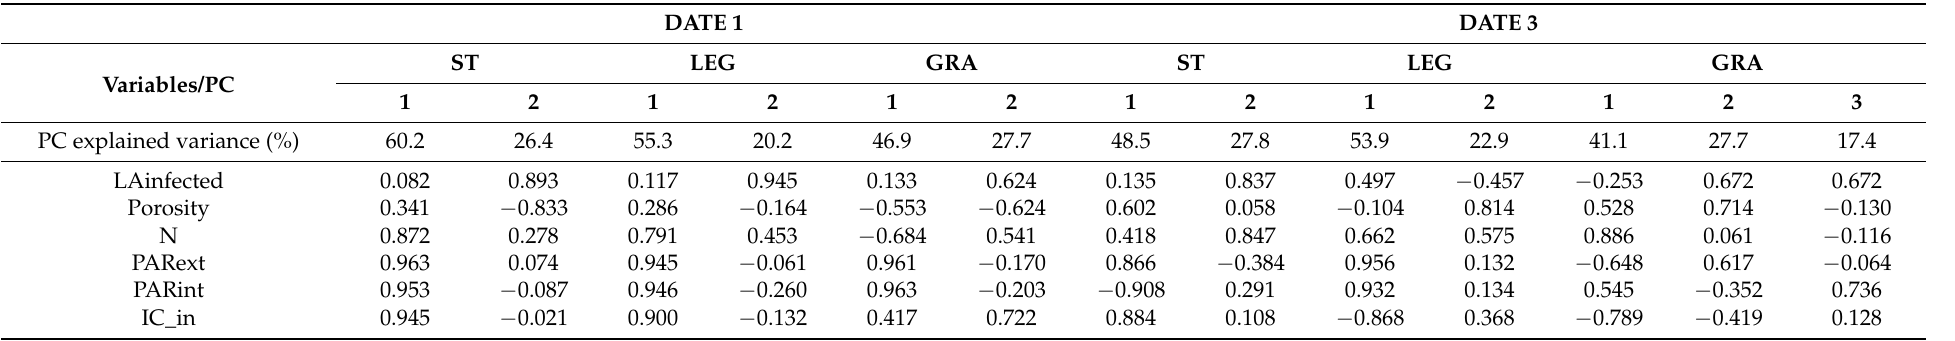
Table A4. Correlations between the principal components and the original variables in the multifactor analysis, showing significant differences among soil management treatment during the dates 1 and 3 of grapevine and downy mildew